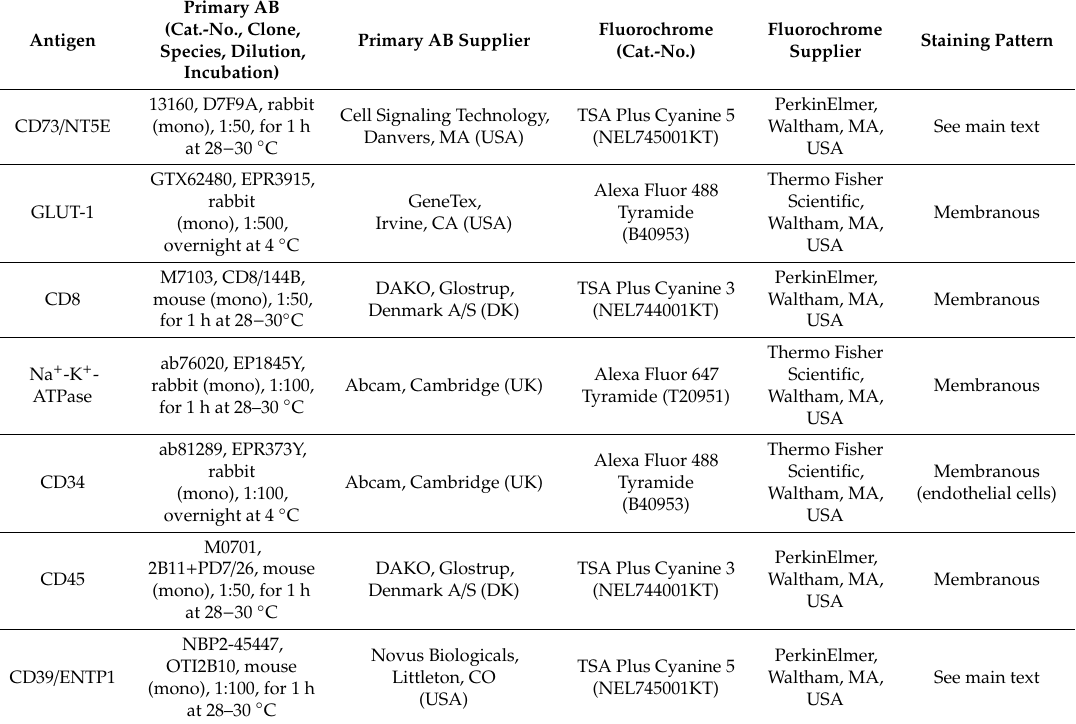
Table 2. Antibodies (AB), immunohistochemistry (IHC) protocol and resulting staining patterns.